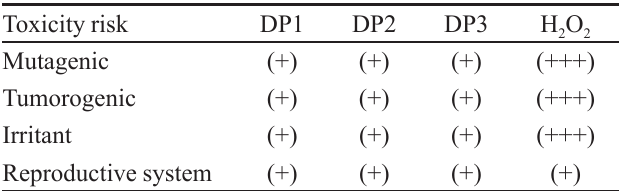
The scale of risk of toxicity varies from low (+), medium (++) and high (+++) calculated using the Osiris Property Explorer